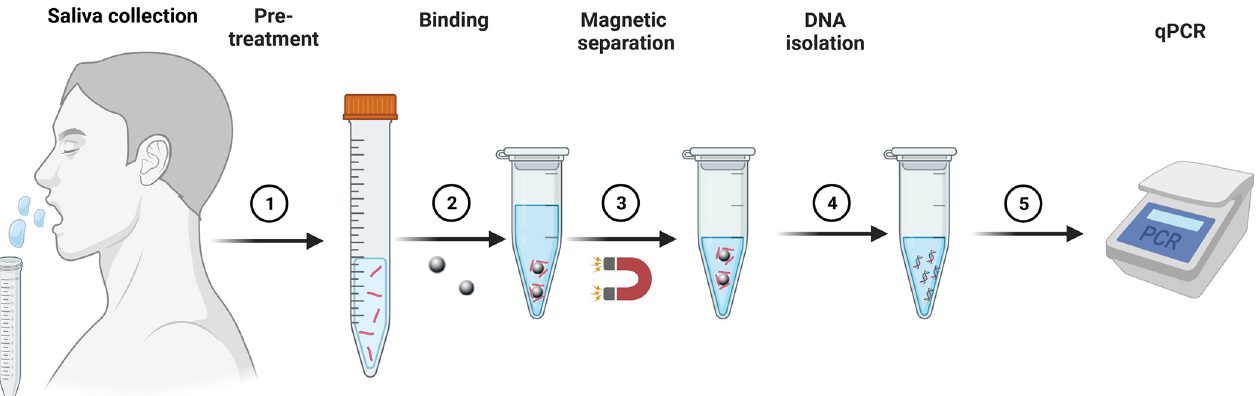
Fig 6. Schematic illustration of the Lipobiotin magnetic bead assay (LMB assay). After saliva collection, saliva samples were pre-treated with proteinase K (18U/ml) and dithiothreitol (DTT, 2mM) for 45 mins at 37˚C (Step 1). Lipobiotin-functionalized magnetic beads (4.6x10 6 LMBs) were added and samples incubated for 60 mins at 37˚C (step 2). Subsequently, beads were isolated by centrifugation and by use of a magnet (DynaMag-2 Magnet) (Step 3). After this step, samples were heat-treated (95˚C, 30 mins) and extracted DNA purified and concentrated by ethanol precipitation (Step 4). Finally, samples were subjected to real-time quantitative PCR analysis